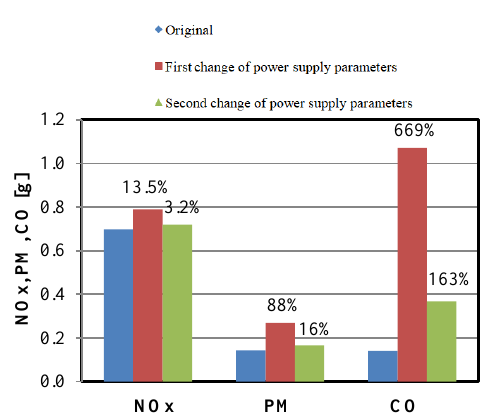
Fig. 13. Mass of toxic compounds during acceleration in similar engine operating